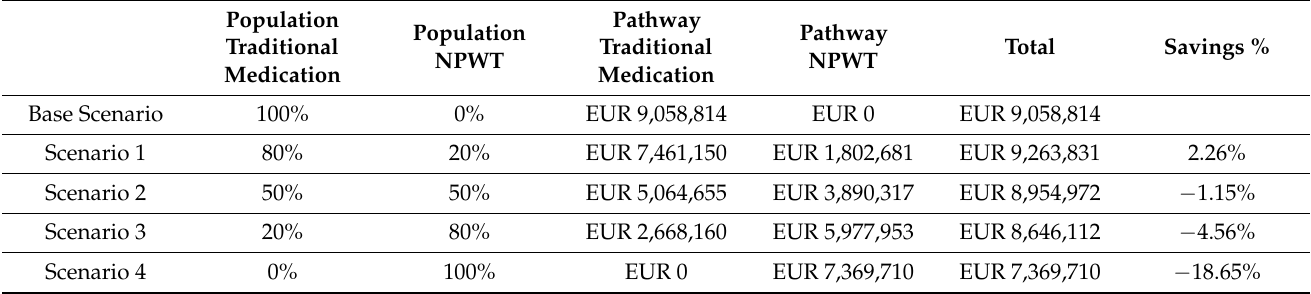
Table 3. Budget impact analysis.